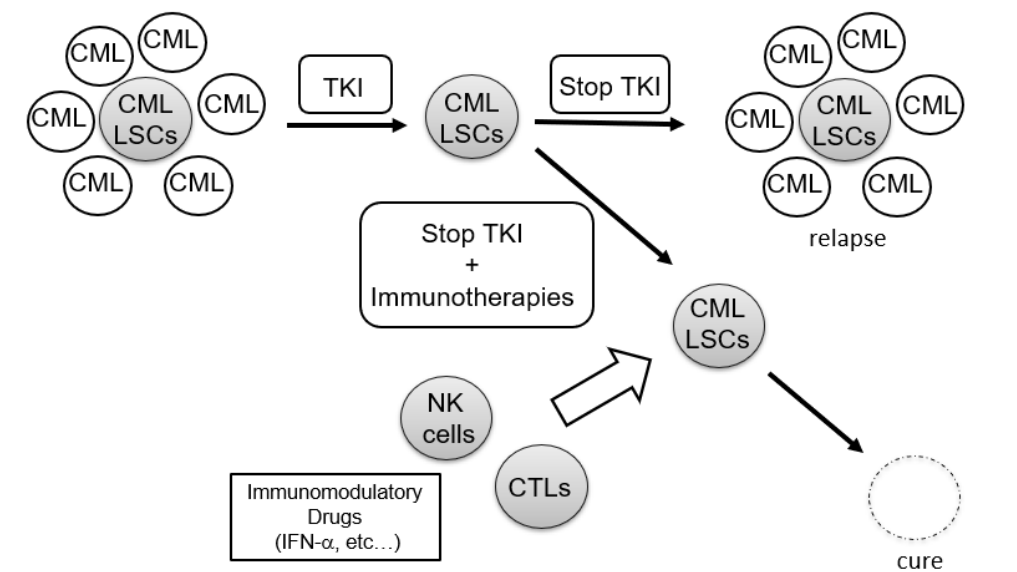
Figure 1. Eradication of CML-LSCs by immunotherapies after TKI therapy. CML, chronic myeloid leukemia; LSCs, leukemic stem cells; TKI, tylosine kinase inhibitor; NK cells, natural killer cells; CTLs, cytotoxic T cells; IFN- α , interferon alpha.